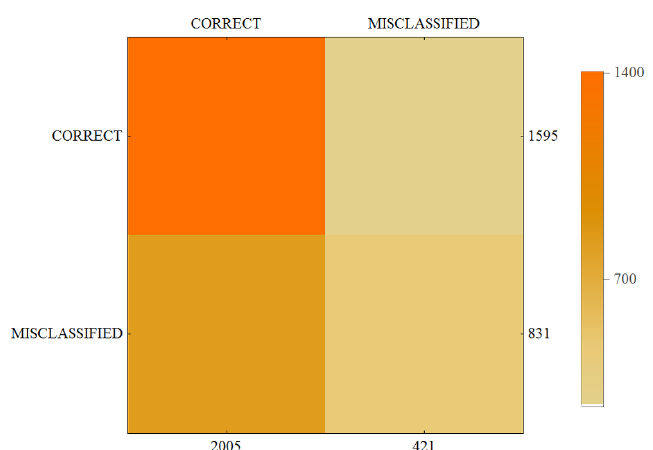
Figure 4. Confusion matrix for User 1.